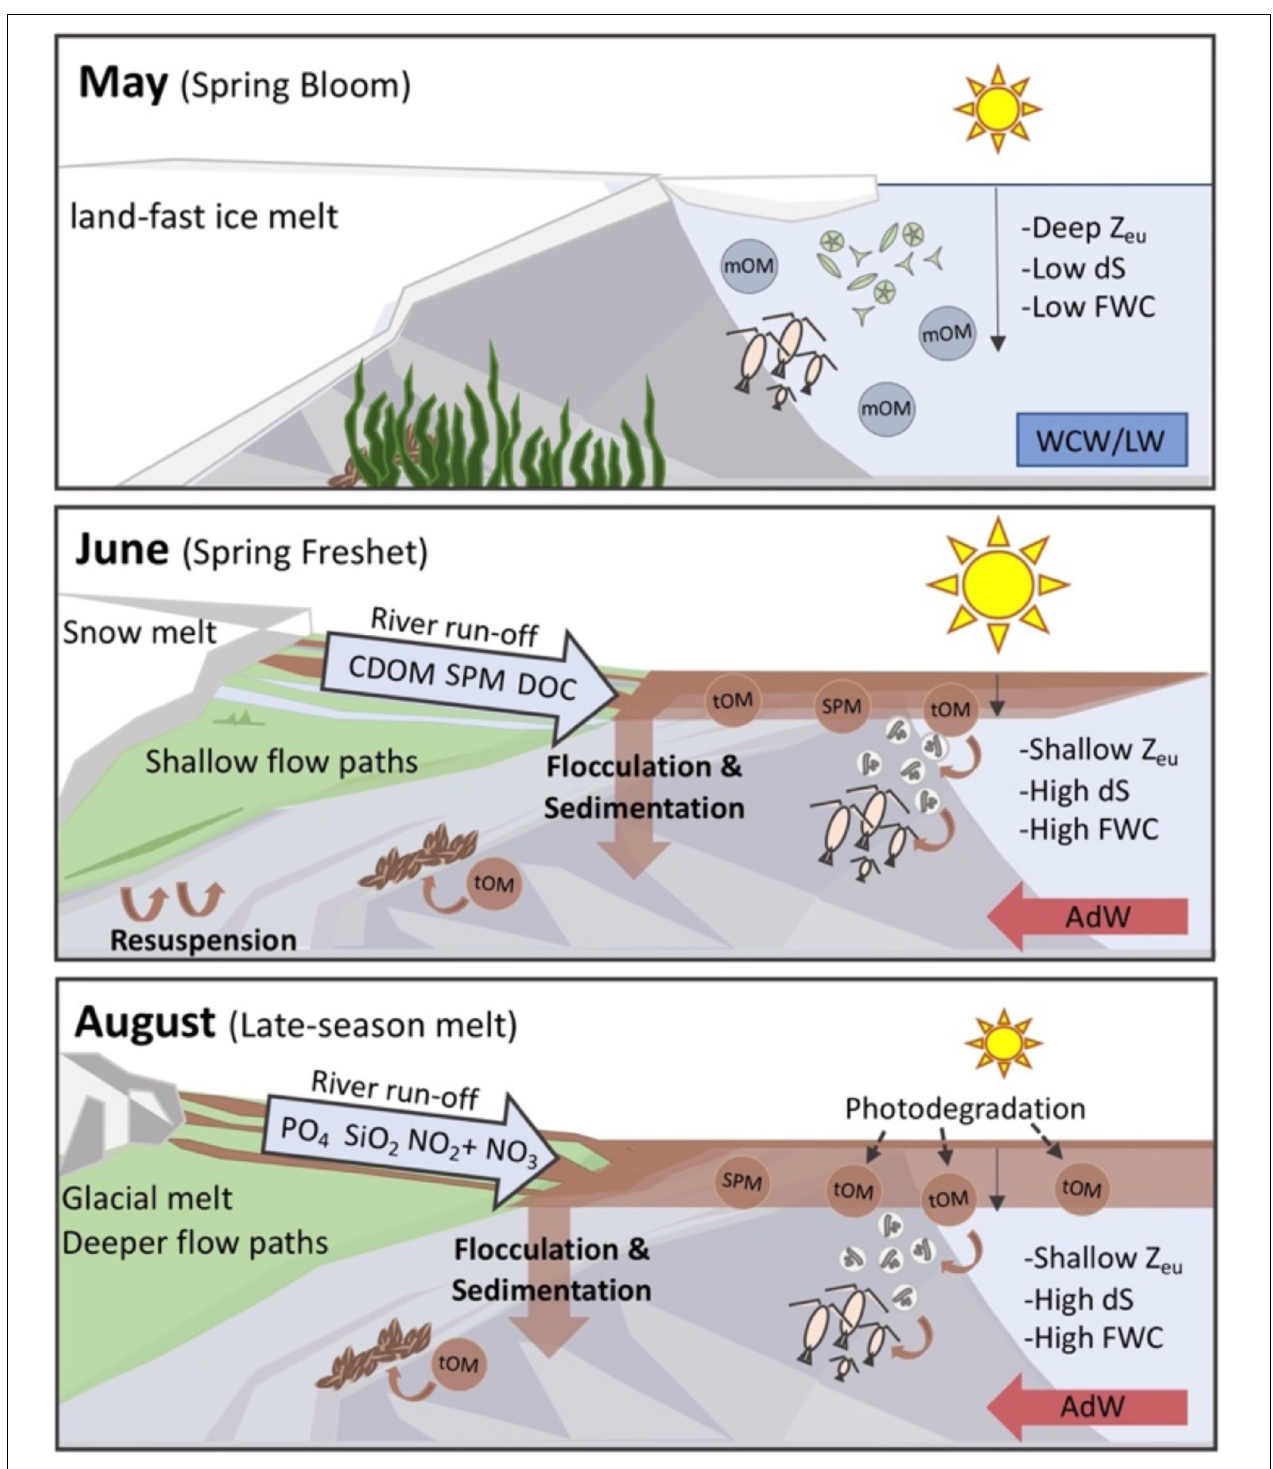
FIGURE 8 | A conceptual diagram summarizing main findings and future perspectives. In May, ice still covered the inner fjord arms of Isfjorden and marine OM (mOM) was present throughout the water column following the spring phytoplankton bloom, when there was a deep euphotic zone (Z eu ). The spring freshet in June was a source of terrestrial DOC and SPM to Isfjorden, and while some of these materials were removed from the water column through flocculation and sedimentation, terrestrial OM (tOM) was observed throughout the highly stratified (dS) and turbid fjord surface waters. In August, glacier-fed rivers with deeper flowpaths were a source of nutrients including nitrogen and phosphorus to Isfjorden. Surface waters also had increased fresh water content (FWC) and degraded OM dominated throughout the fjord in August.